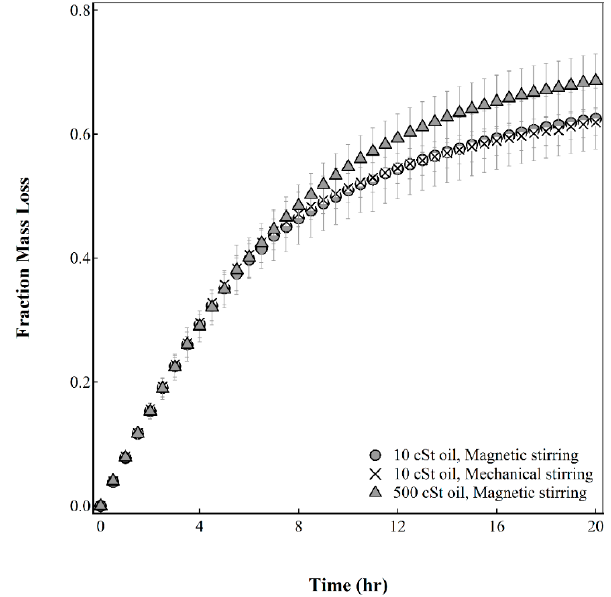
Figure 7. Effect of agitation method and oil viscosity on the fraction mass loss as a function of time. Error bars represent standard deviation, n = 10.